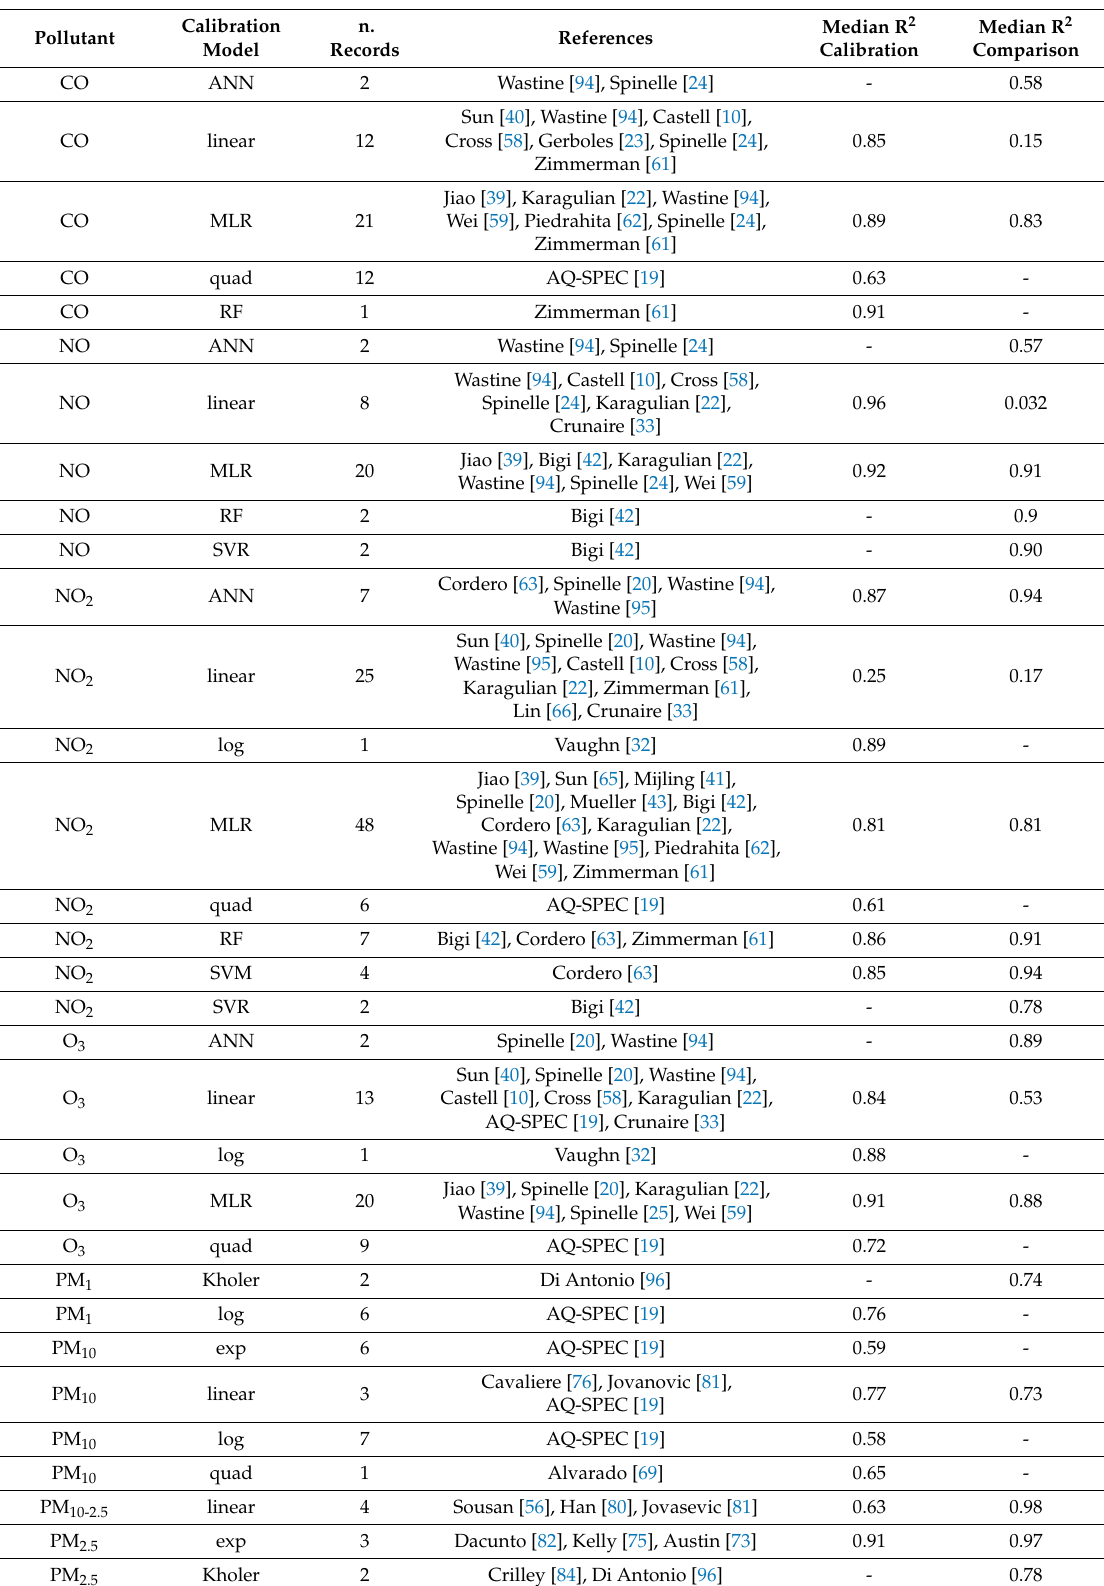
Table 3. Types of calibration models used for the calibration of